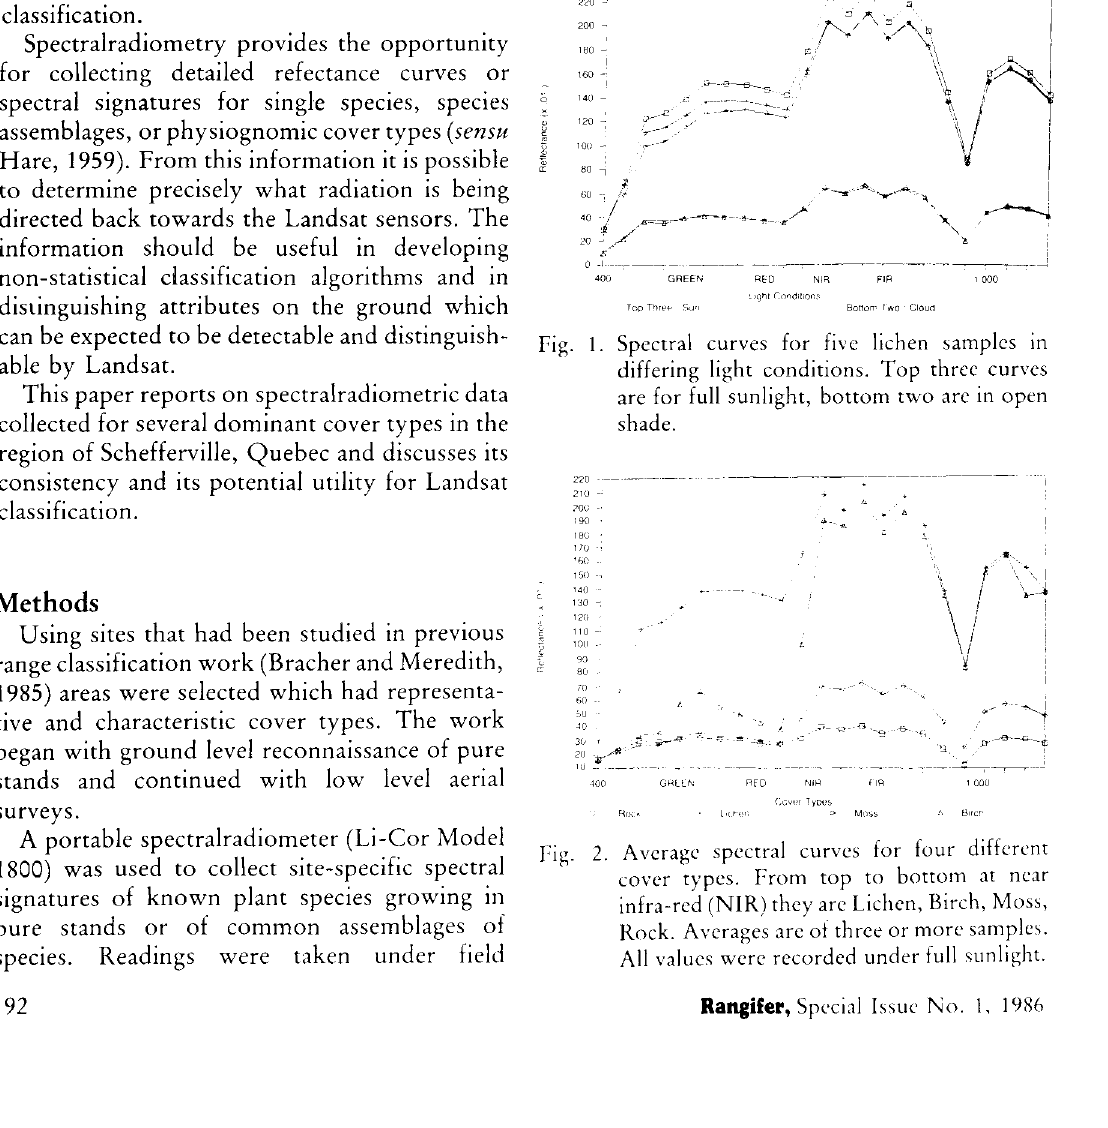
Fig. 2. Average spectral curves for four different cover types. From top to bottom at near infra-red (NIR) they are Lichen, Birch, Moss, Rock. Averages are of three or more